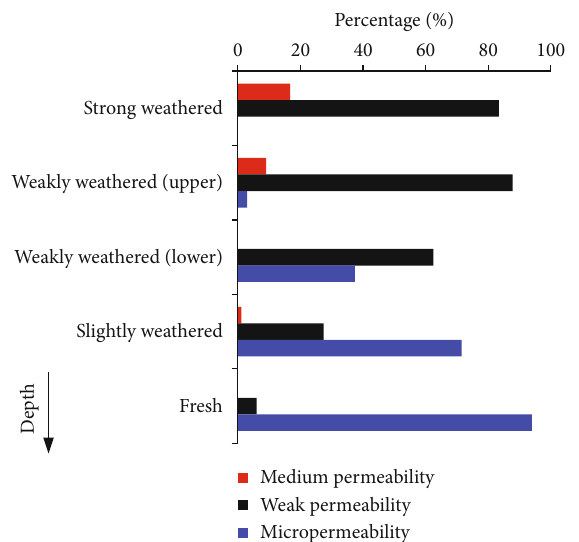
Figure 3: Permeability of granite in the Zhouning pumped storage power station.